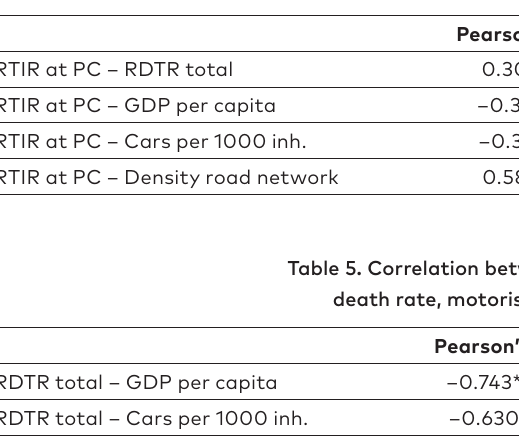
Table 4. Correlation between road traffic injury rate